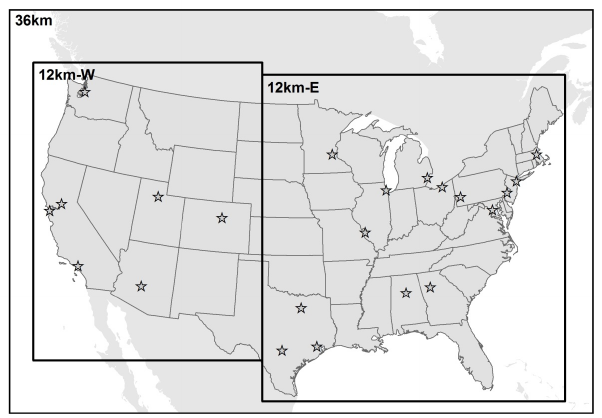
Fig. 3. CAMx North American modeling domain comprised of an outer 36km resolution grid and two inner, two-way nested, 12km resolution grids. The 22 cities used for performance evaluation are